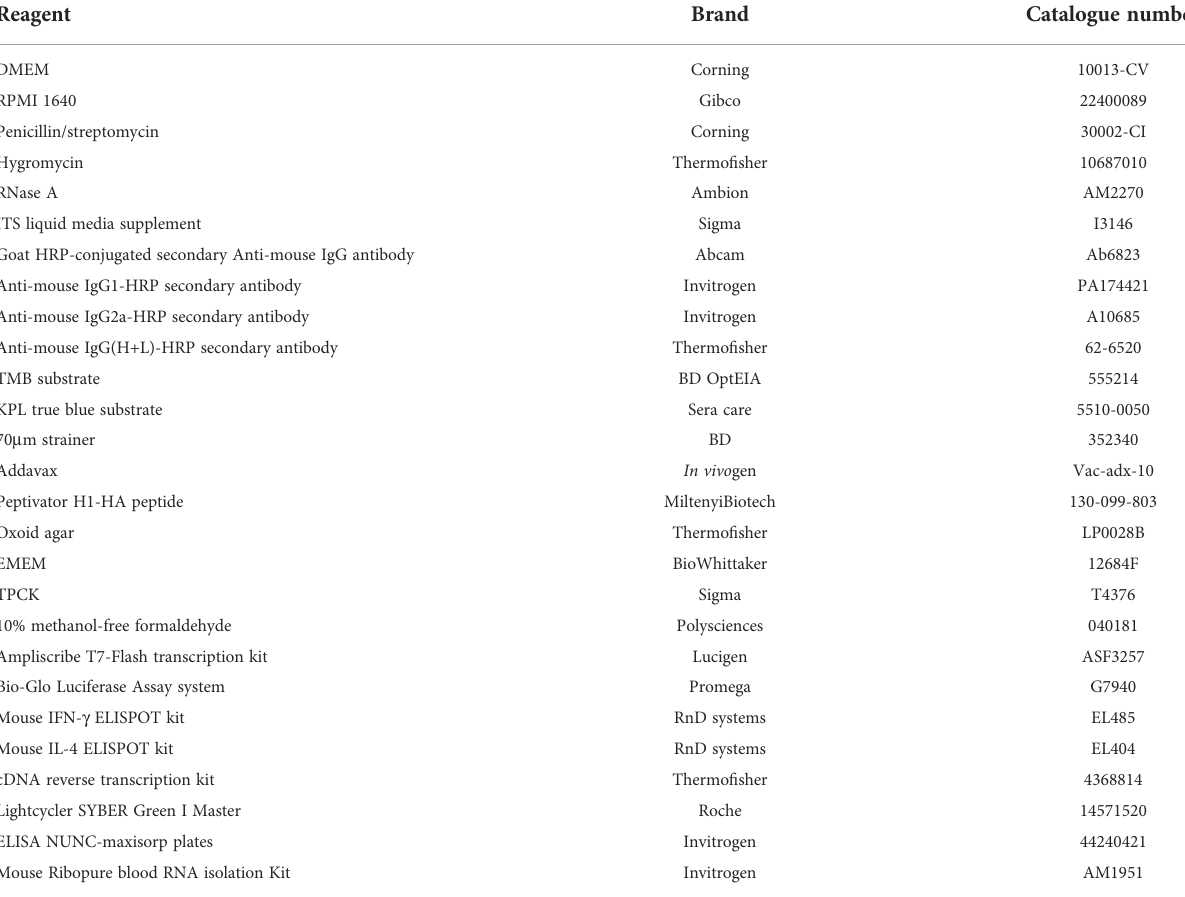
TABLE 1 Source of reagents and kits used in the study.